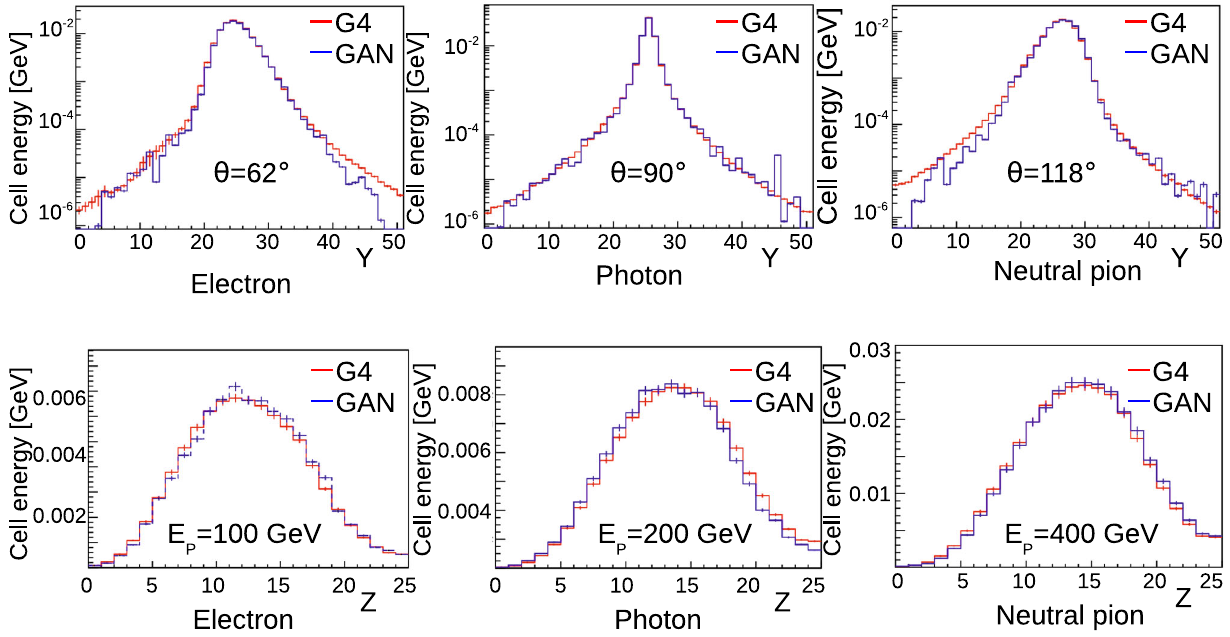
Fig. 8 Shower Shapes for the GEANT4 vs. GAN events as a function of inputs. (Top row) transverse shower shapes along the Y axis: (left) electrons with θ in the 62 ◦ bin; (mid) photons with θ in the 90 ◦ bin; (right) neutral pions with θ in the 118 ◦ bin. (Bottom row) longitudinal